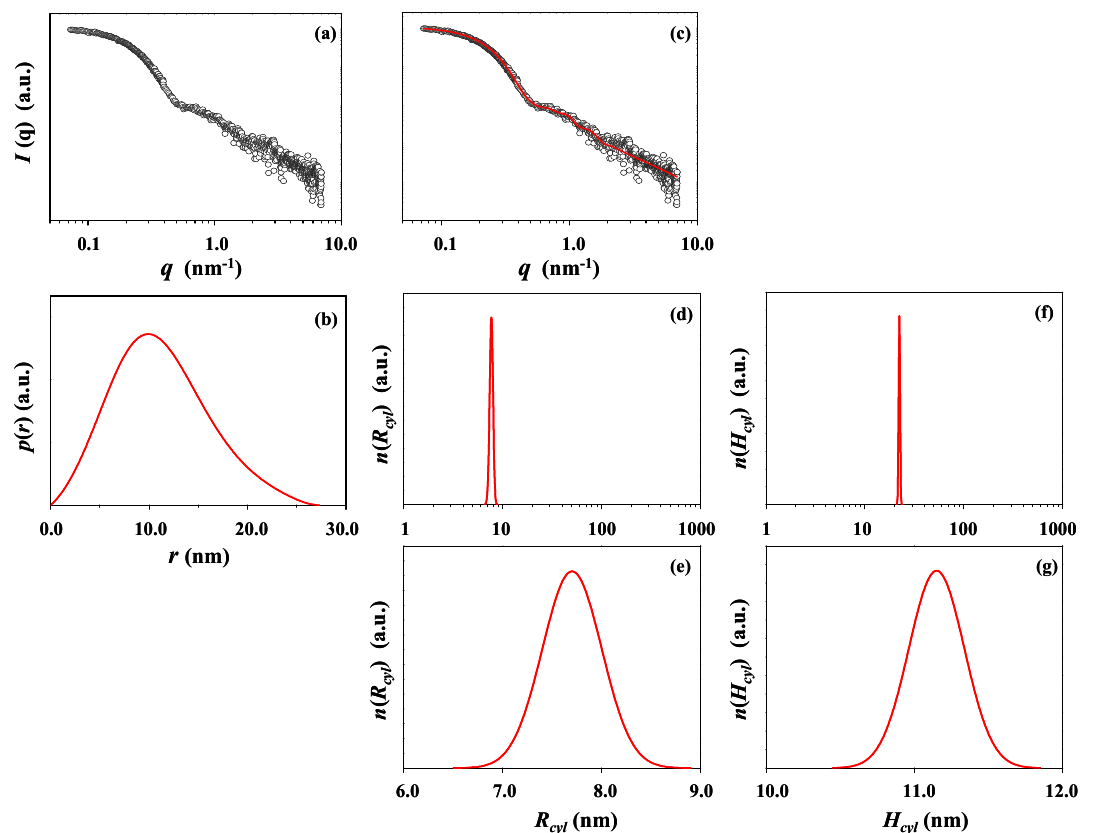
Figure 7. X-ray scattering data analysis of the l -PPCGE- b -PDDGE micelle formed in chloroform: ( a ) scattering data measured at room temperature; ( b ) pair distance distribution functions p ( r ) obtained by the data analysis using the IFT method; ( c ) data analysis result, where the open dot symbols are the measured data and the red solid line was obtained by fitting the data using the three-phase cylinder approach; ( d , e ) radius distribution obtained by the data analysis; ( f , g ) height